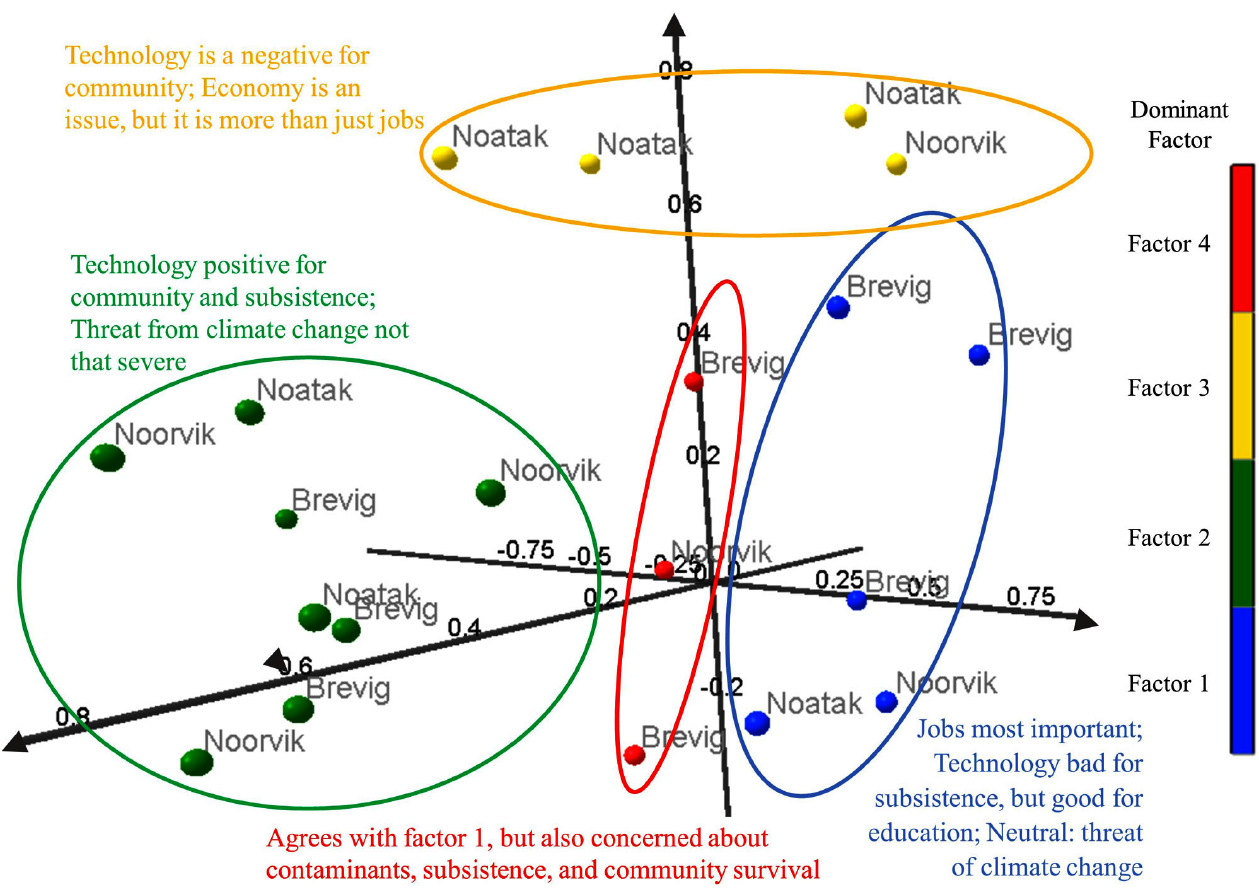
Fig. 4 . Results from Q-sort on attitudes toward technology by interviewees in Noatak, Noorvik, and Brevig Mission in March 2017. One interviewee did not sort into any